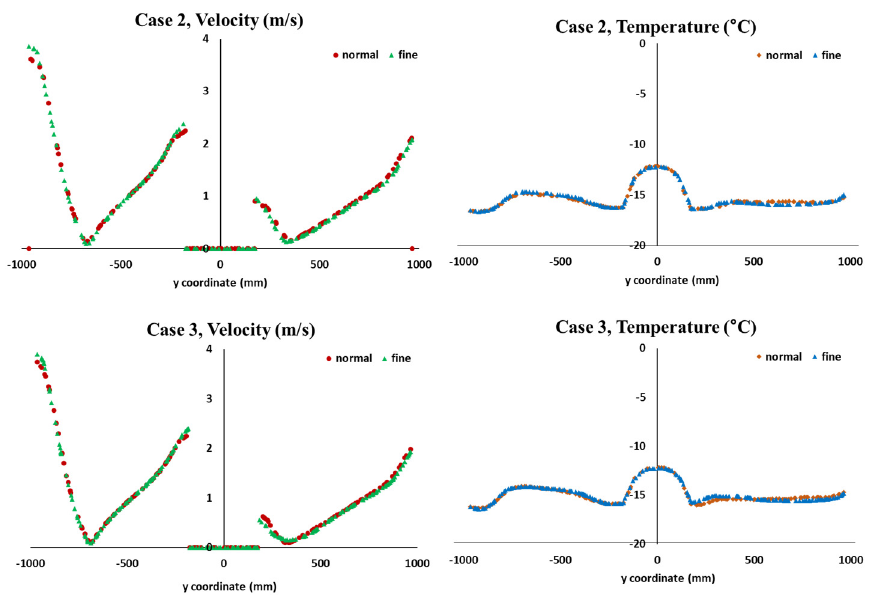
Figure 9. Comparison of velocity and temperature distribution depending on mesh size in y-coor- dinate (x = 0, z =